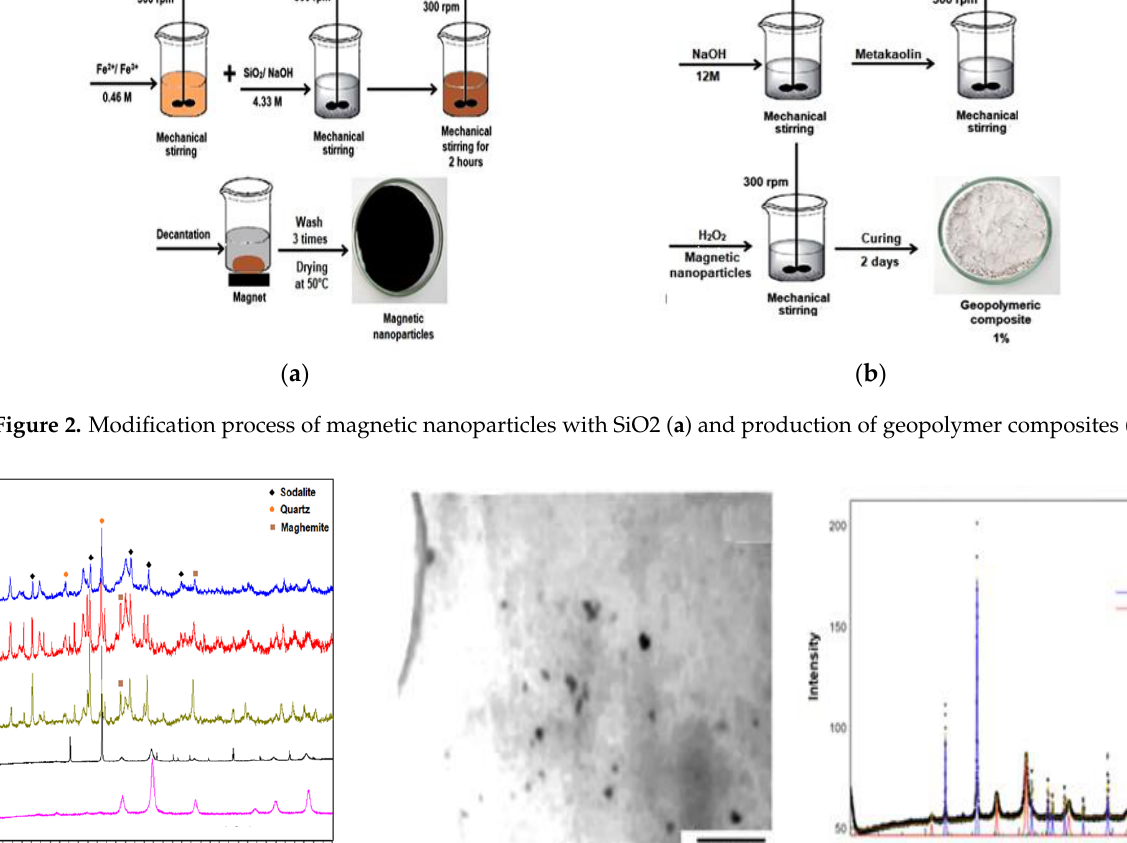
Figure 4. Normalized magnetic force as a function of the magnetic field for magnetite ( a ) and silica- modified ( b ) samples.